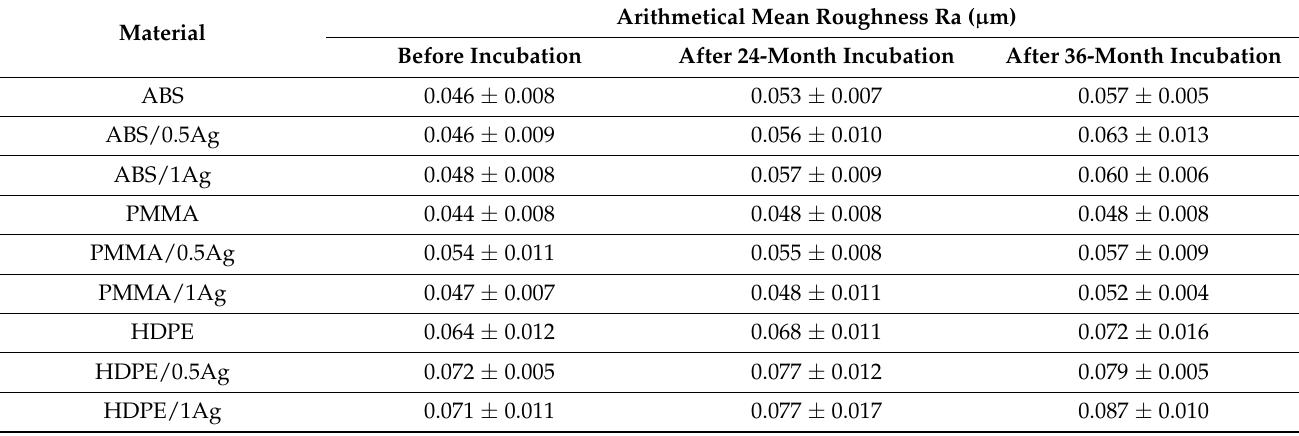
Table 1. Results of the arithmetical mean roughness of polymers and composites modified with 0.5 wt.% and 1.0 wt.% AgNPs.